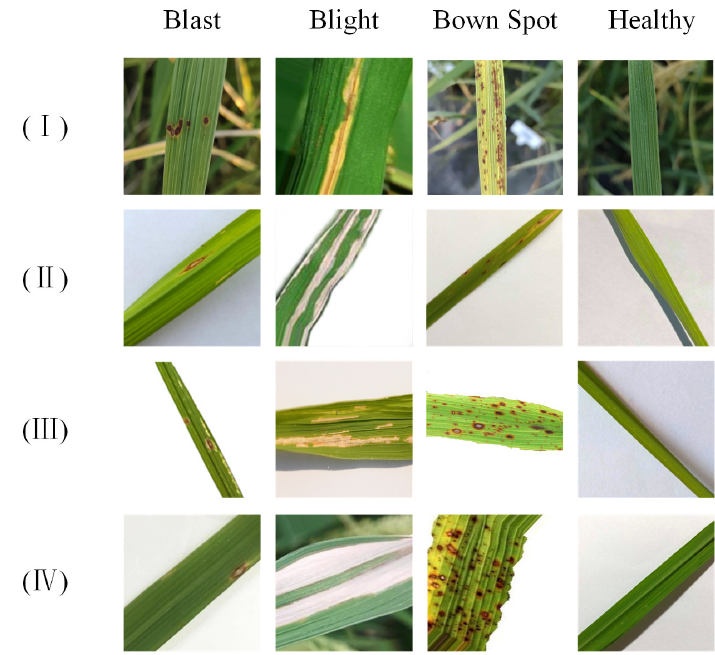
Figure 1. Images of rice diseases